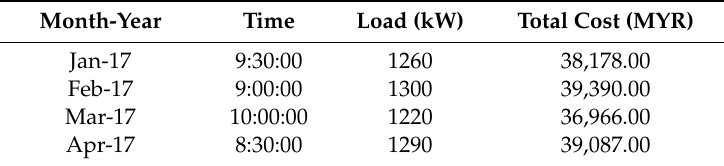
Figure 4. Actual solar irradiance measurement data at Nilai, Negeri Sembilan, Malaysia. Table 4. Maximum demand captured during peak hours.